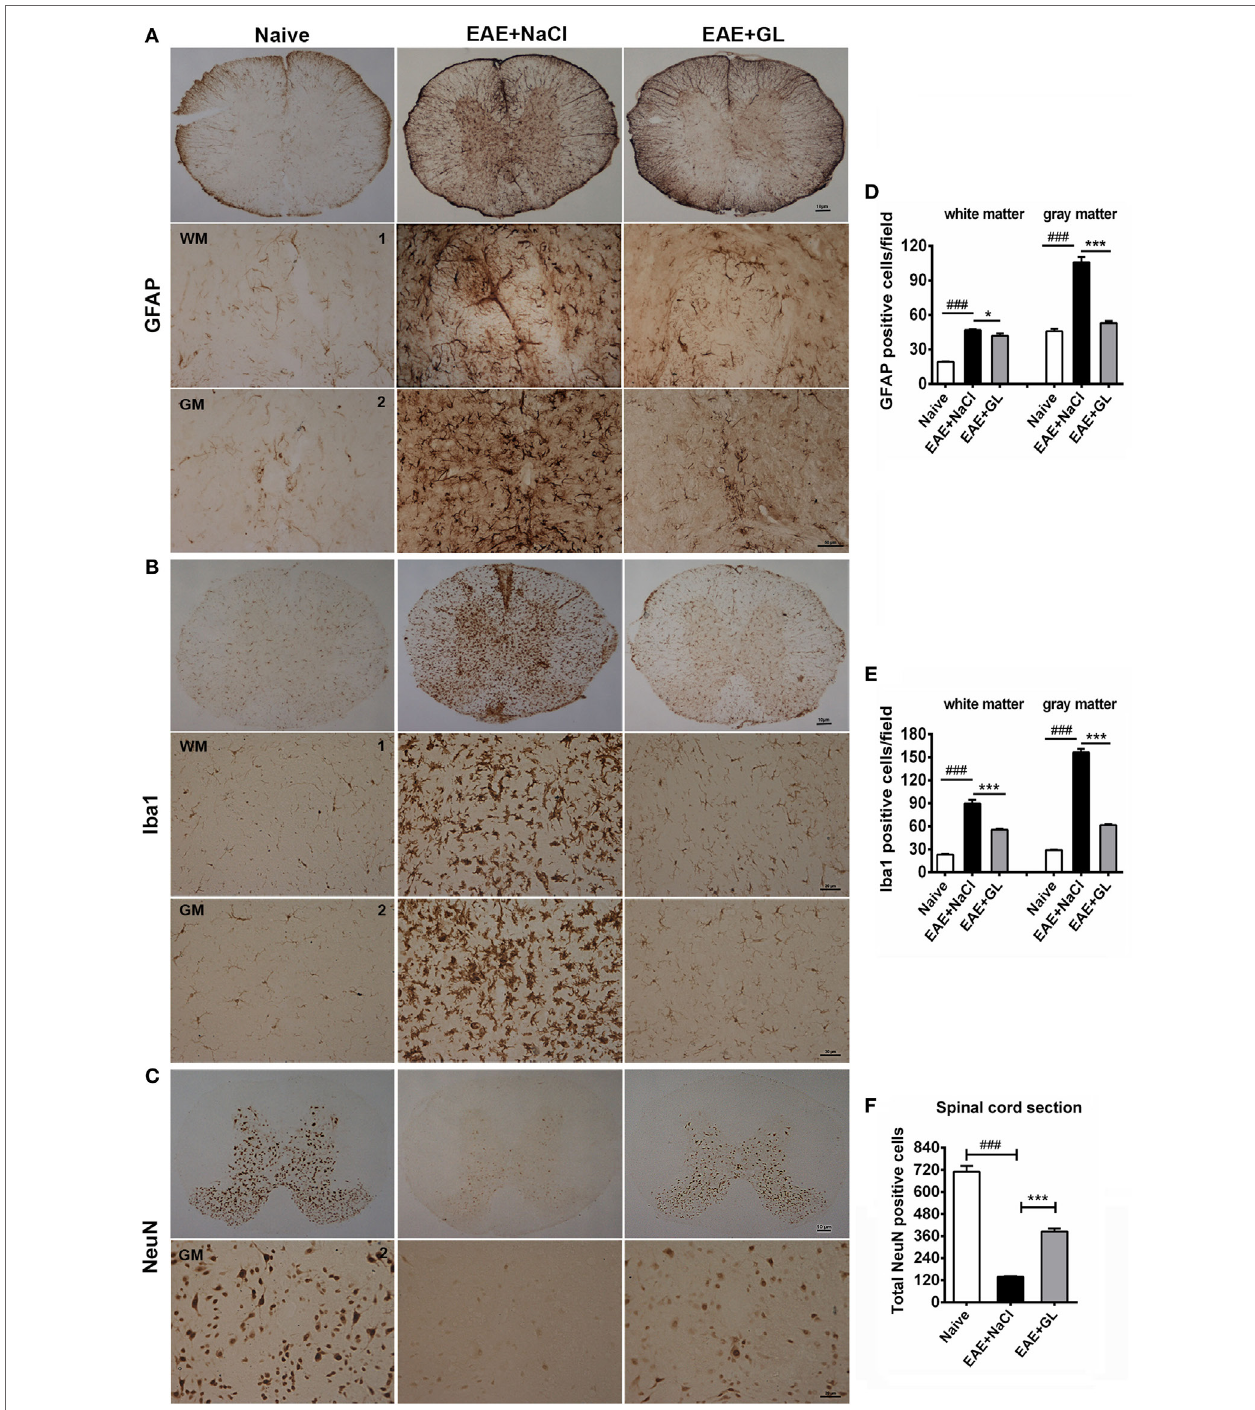
FigUre 3 | Activated astrocytes, microglia, and damaged neurons in the spinal cord of experimental autoimmune encephalomyelitis (EAE) mice treated with glycyrrhizin (GL). Immunohistochemical staining for glial fibrillary acidic protein (GFAP), Iba1, and NeuN in thoracic spinal cord sections of naive mice and EAE mice treated with either NaCl or GL obtained at day 25 post-immunization. 1: dorsal column; 2: central canal. (a) GFAP-positive cells. Scale bars were 10 µm for low magnification and 50 µm for high magnification. (B) Iba1-positive cells. Scale bars were 10 µm for low magnification and 20 µm for high magnification. (c) NeuN-positive cells. Scale bars were 10 µm for low magnification and 20 µm for high magnification. (D–F) The number of GFAP-positive cells, Iba1-positive cells, and NeuN-positive cells in spinal cords. At least six serial thoracic spinal cord sections were analyzed from each mouse, and six mice were included in each group. Data are shown as the mean ± SEM. ### P < 0.001 vs naive group; * P < 0.05, *** P < 0.001 vs EAE + NaCl group, statistical significance ( P ) was determined by one-way ANOVA with Bonferroni’s test.